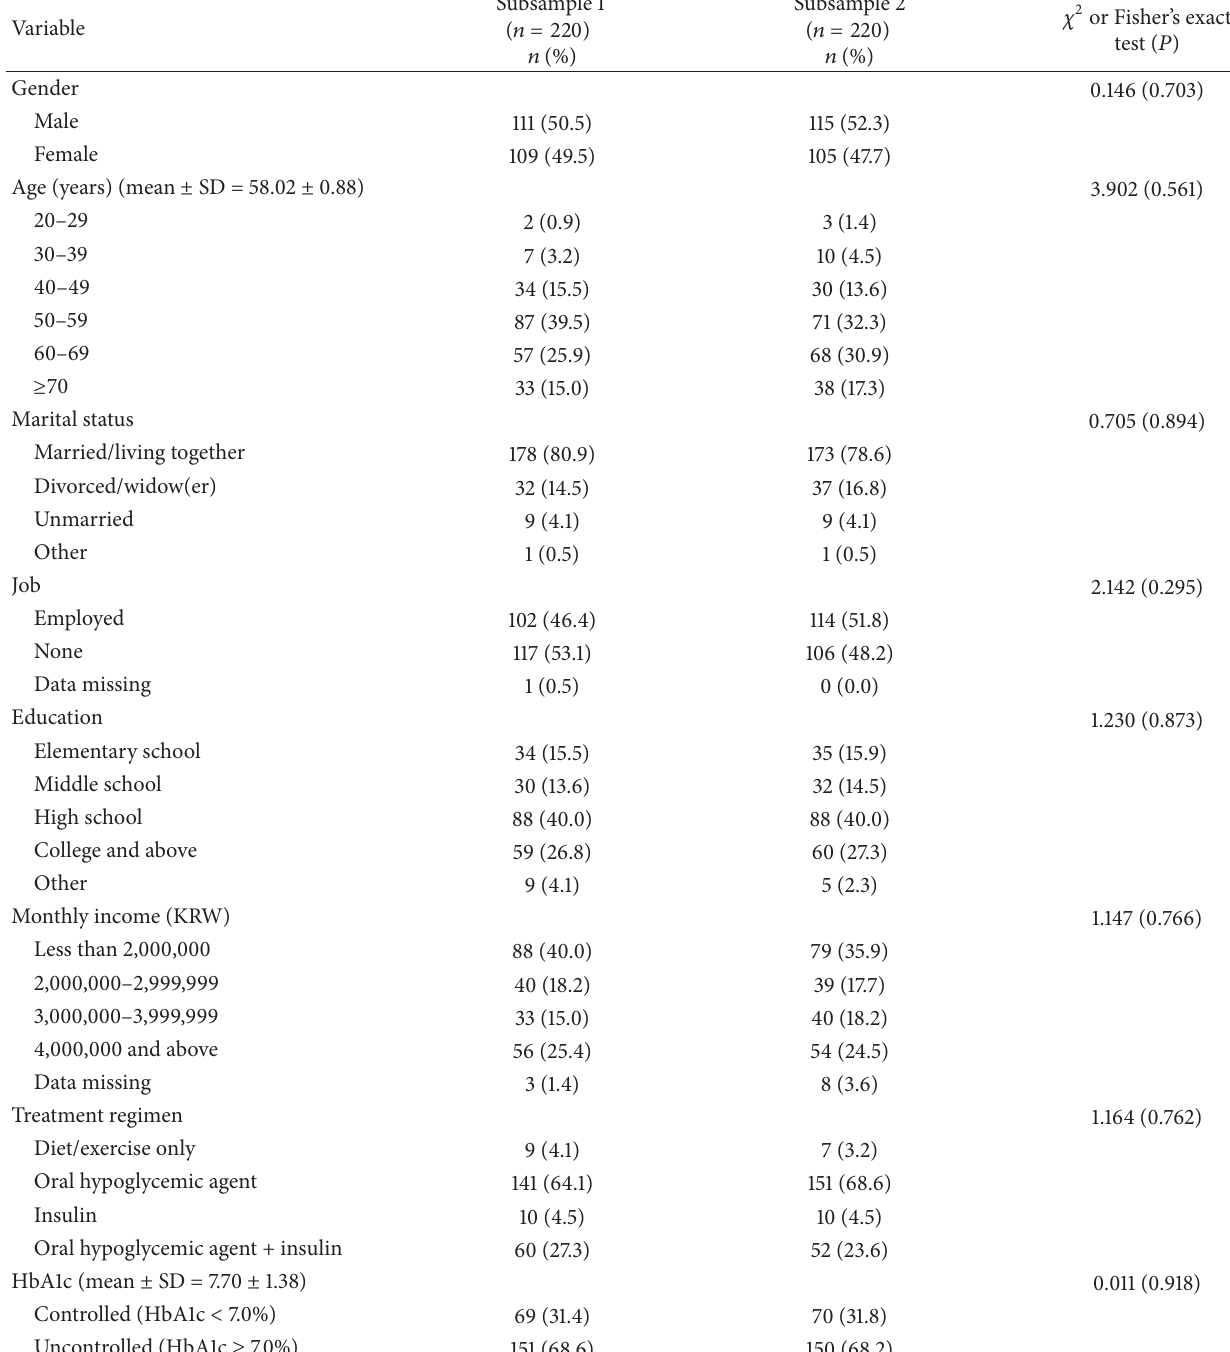
Table 1: General